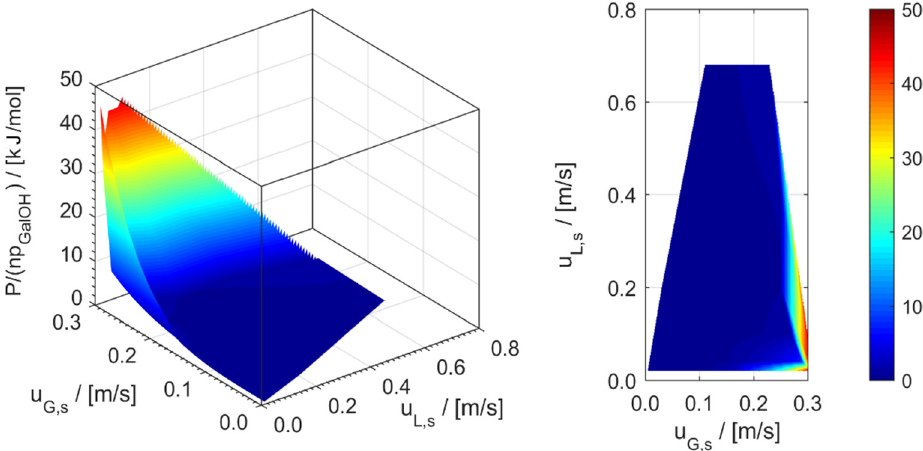
Figure 8. Specific energy consumption of minichannel wall reactors operating in the Taylor flow mode of different gas and liquid superficial velocities.